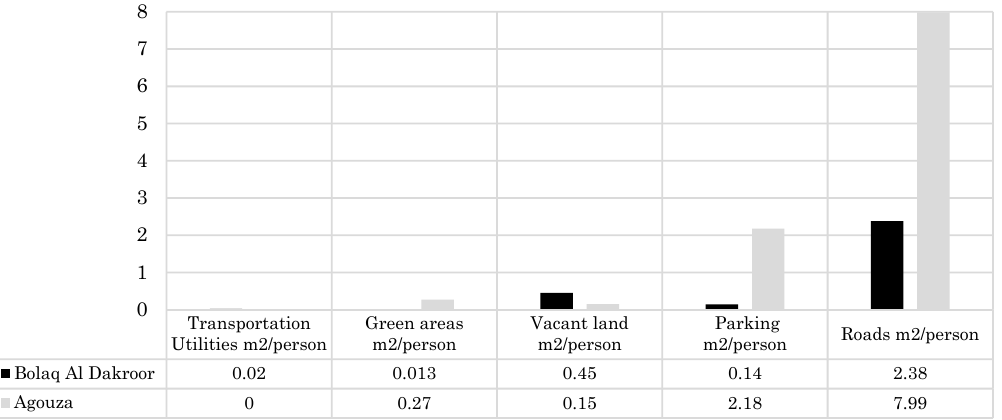
Figure 9. Open spaces in